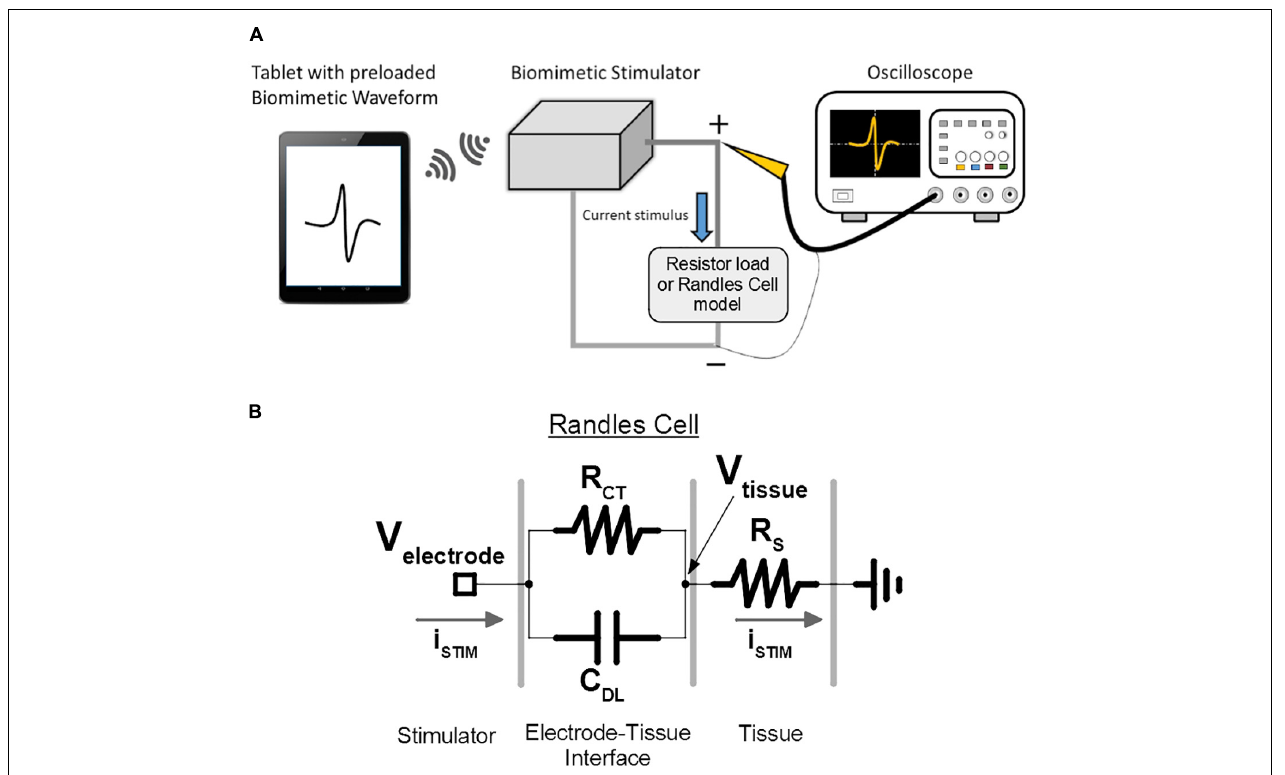
FIGURE 10 | Bench-top test setup is used for verification and demonstration of the prototype of the proposed biomimetic stimulator. (A) The illustrated arbitrary waveform is sent to the stimulator, which delivers the current-mode protocol to the emulated loads. The resulting voltage output is captured by the oscilloscope. (B) The electrode-tissue interface of the spinal cord epidural electrode is modeled by a Randles cell to investigate the stimulator performance under delivery of DS protocol. V tissue node represents the resulting voltage potential experienced by the neural tissue, which doesn’t include the capacitive effects of C DL . V electrode node represents the voltage experienced by the SoC’s output current sources, which includes the effect of C DL